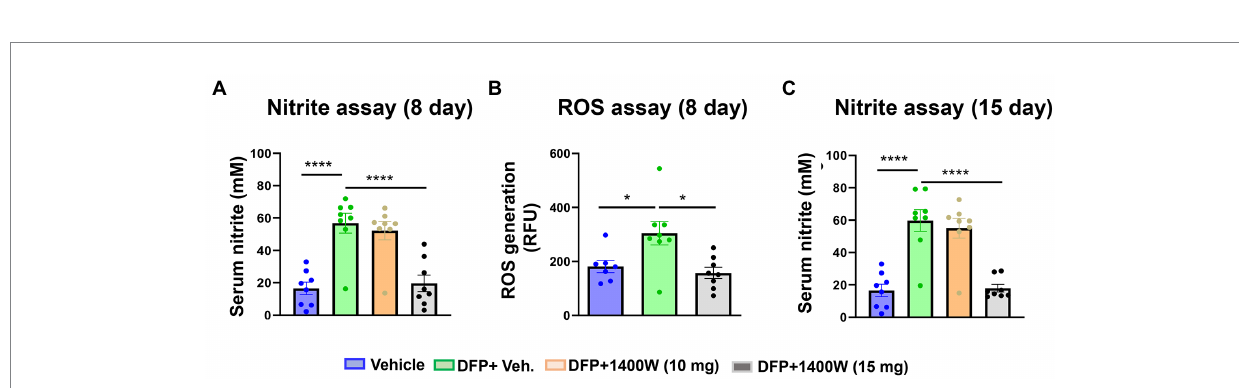
FIGURE 9 The effects of DFP and 1400W on serum nitro-oxidative stress markers. At 8-day post DFP, 1400 W (15 mg/kg) significantly reduced serum levels of nitrite and ROS levels in DFP exposed rats (A,B) . At 15-day post DFP, 1400 W (15 mg/kg) significantly reduced serum nitrite in DFP exposed rats (C) , n = 8, one-way ANOVA with Tukey’s post-hoc for multiple comparisons; * p < 0.05, ** p < 0.01, *** p <